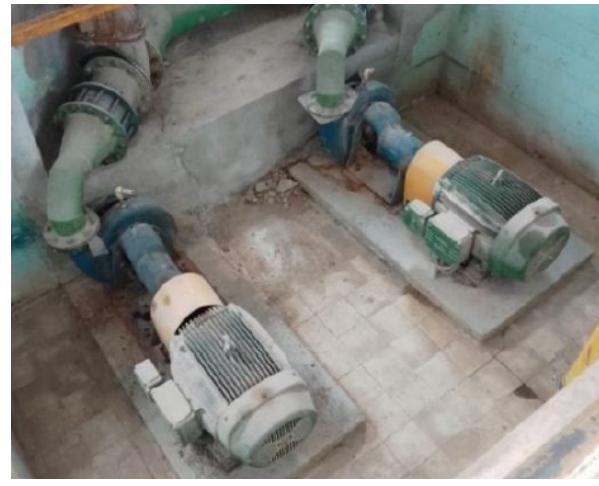
Figure 9. Motor-pump sets. Source: author.